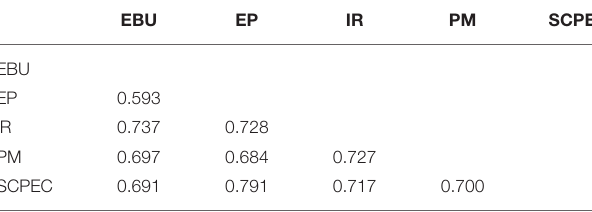
TABLE 4 | Heterotrait Monotrait (HTMT) ratio.